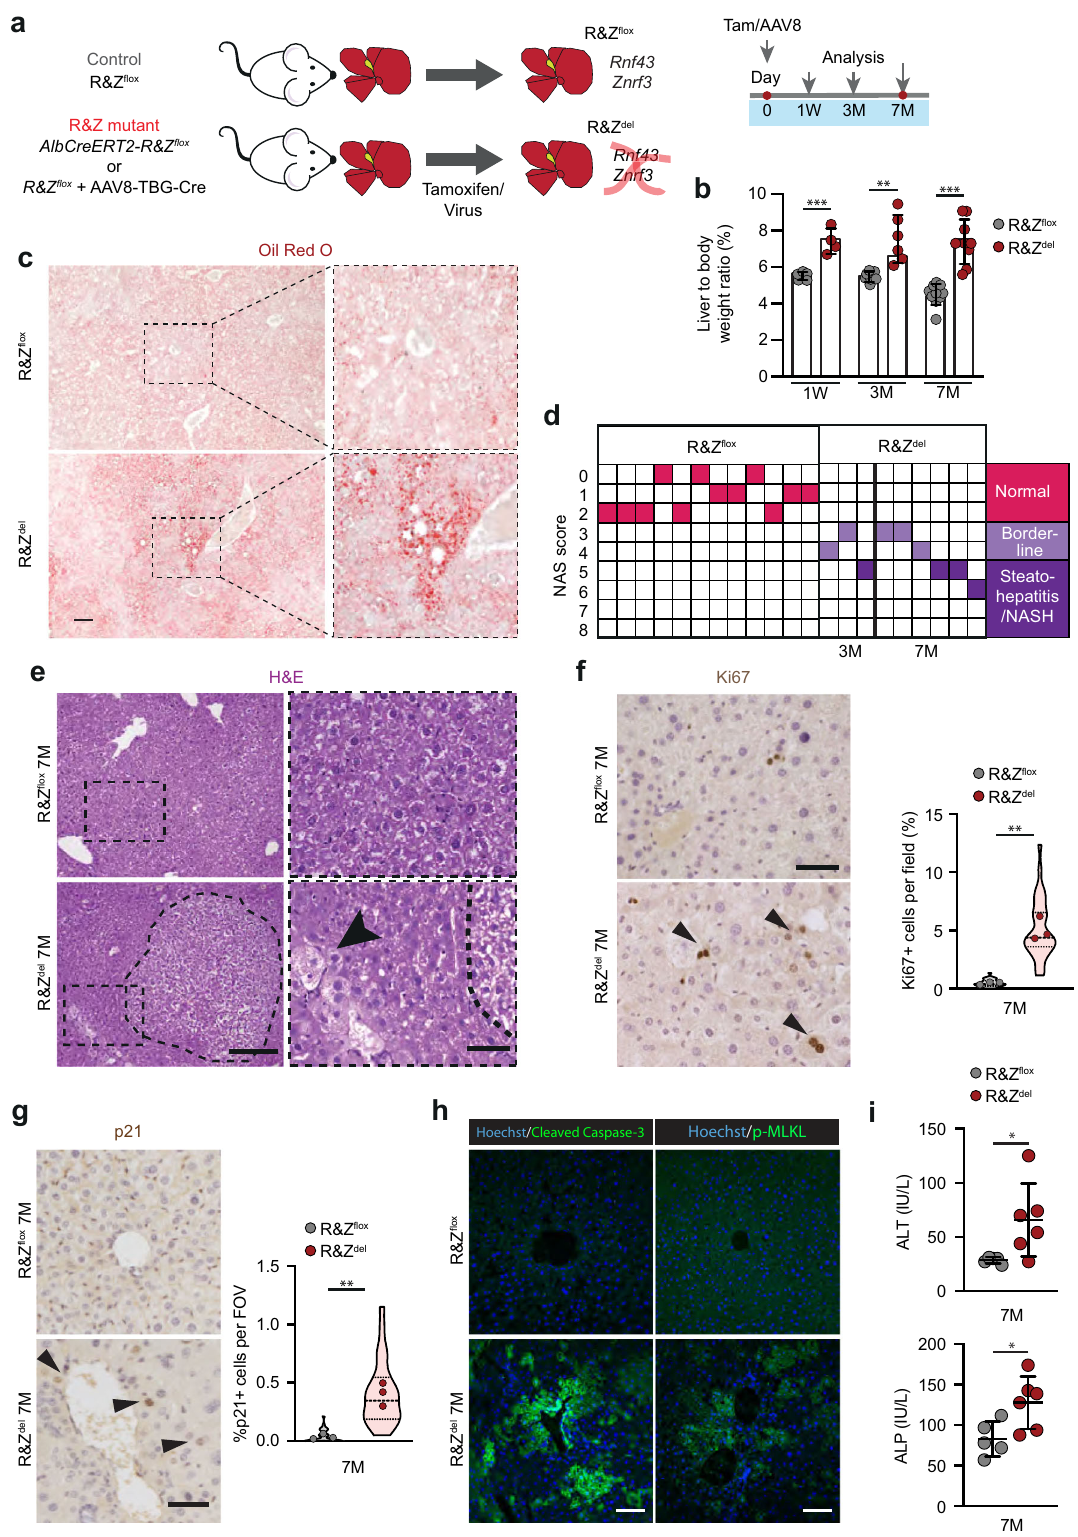
RNF43/ZNRF3 control liver lipid metabolic gene expression . We next performed global gene expression analysis (RNA sequencing (RNAseq)) of Rnf43/Znrf3 del and corresponding controls ( Rnf43/Znrf3 fl ox ) at several time points after gene dele- tion (1, 3 and 7 months). Principal component analysis (PCA) revealed that Rnf43/Znrf3 del mutants clustered together